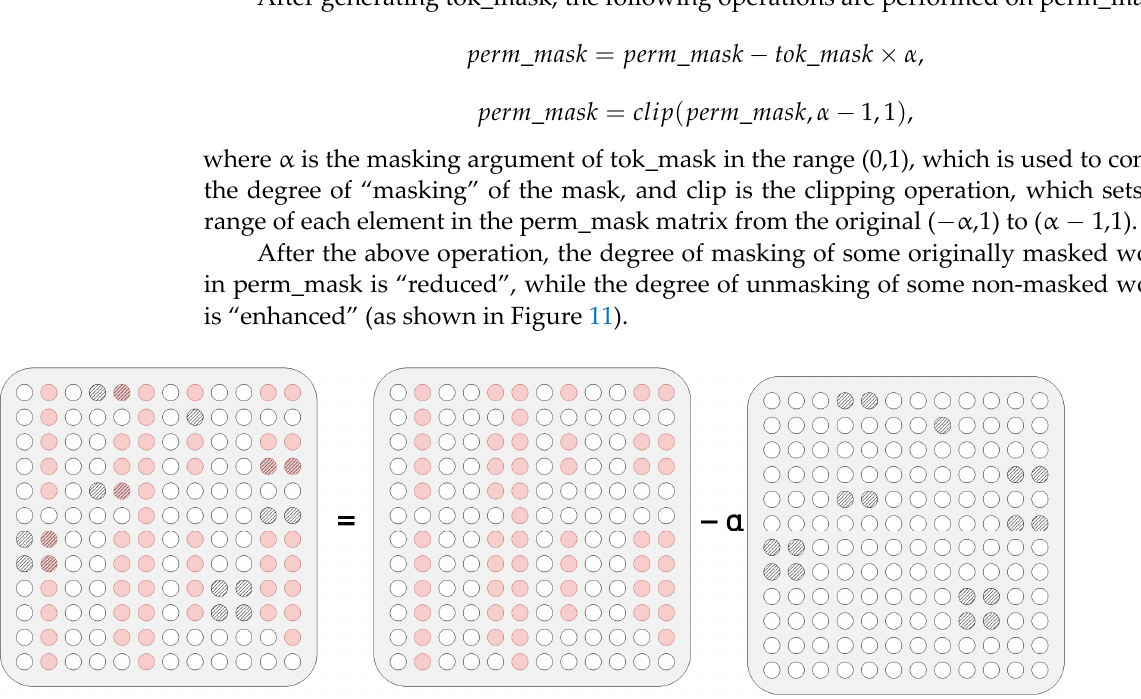
Figure 11. Masking of perm_mask.